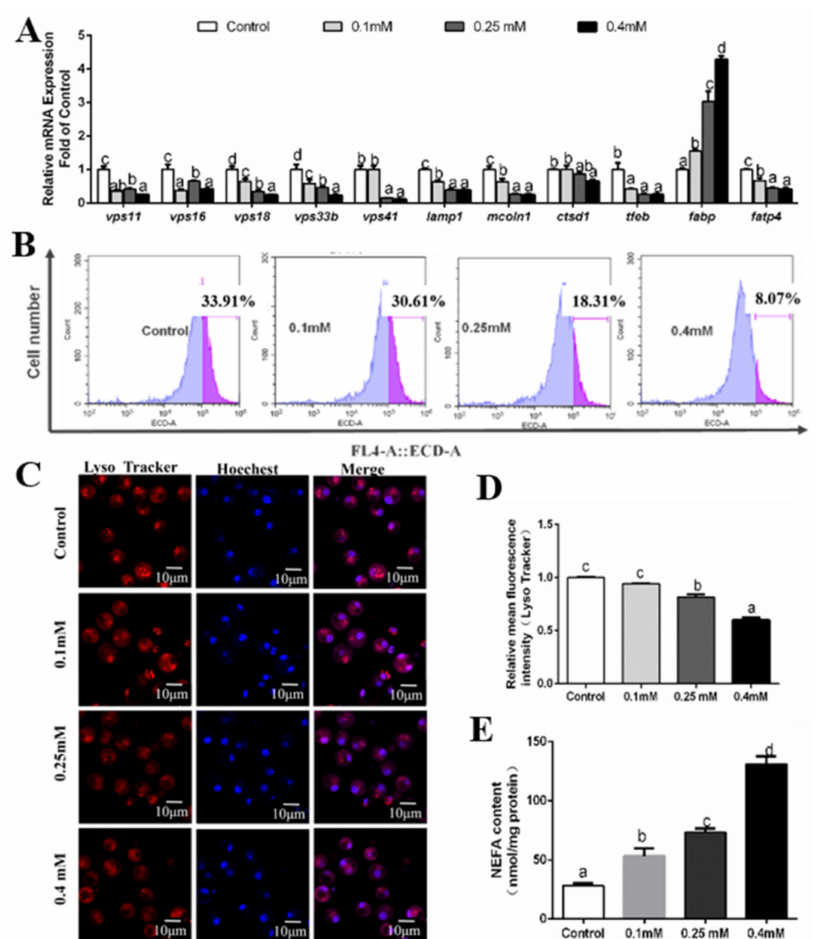
Figure 7. E ff ects of 24 h OA incubation on autophagosomes in hepatocytes of P. fulvidraco. ( A ) E ff ects of 24 h OA incubation on the mRNA levels of autolysosomes related genes; data (mean ± SEM, n = 3) were expressed relative to expression of housekeeping genes ( gapdh and 18s rRNA (M = 0.1887)). ( B ) The e ff ect of 24 h OA incubation on intracelluar autolysosomes demonstrated by flow cytometry analysis of the presence of Lyso Tracker-stained intracellular autolysosomes. ( C ) Representative confocal microscopy image of hepatocytes co-stained with Hoechest (blue) and Lyso Tracker (red) after 24 h OA incubation. ( D ) The e ff ect of 24 h OA incubation on intracelluar autolysosomes demonstrated by flow cytometric analysis of red (FL4) mean fluorescence intensity. ( E ) E ff ects of 24 h OA incubation on NEFA content. Letters ( a–d ) denote significance, p <